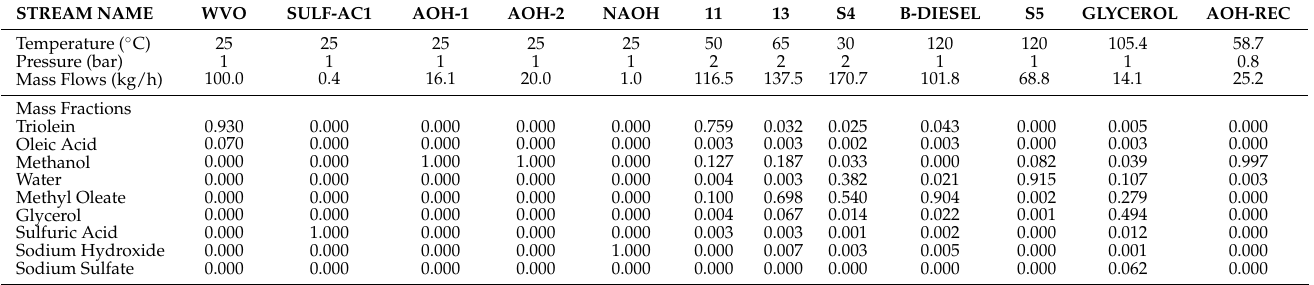
Table 2. Operating conditions and mass compositions of simulation streams. Alkaline